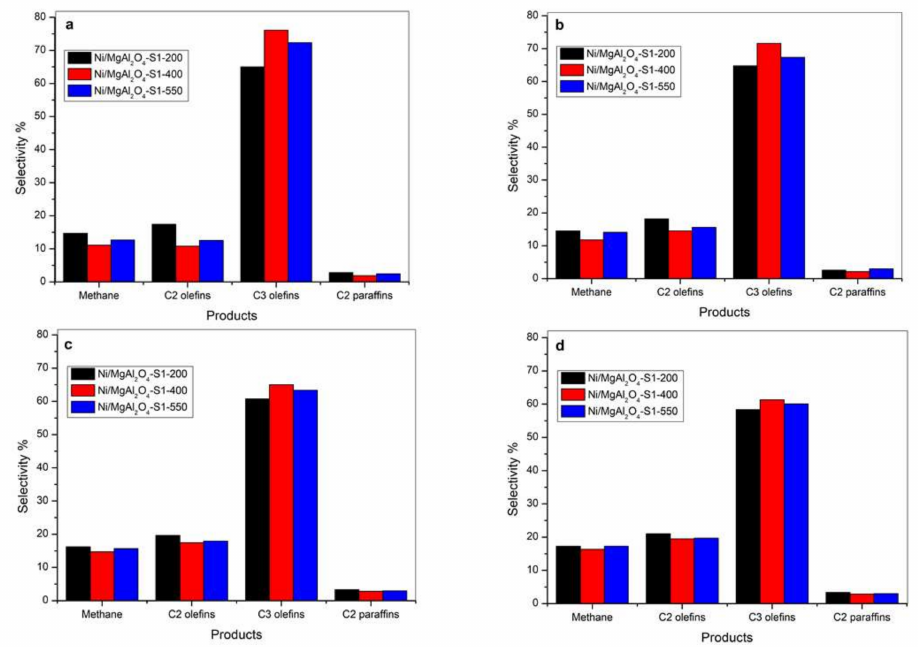
Figure 15. Selectivity % of Ni/MgAl 2 O 4 sulfided with (NH 4 ) 2 SO 4 at ( a ) 3 min, ( b ) 30 min, ( c ) 60 min, and ( d ) 120